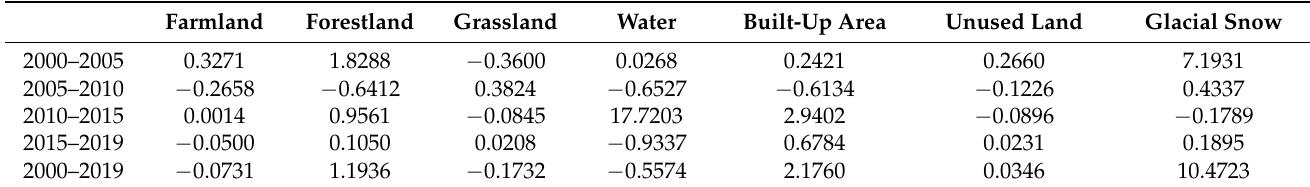
Table 5. Contribution rate of land use intensity by land type in Qilian Mountain National Park (Gansu